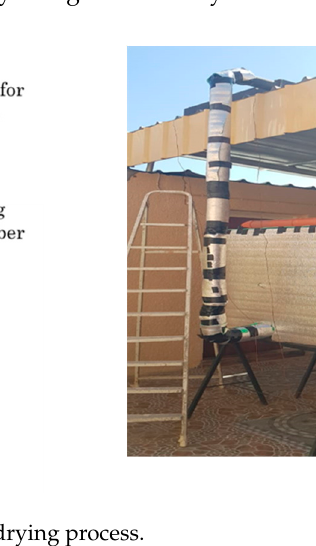
Figure 1. Indirect solar dryer for herbs drying process.